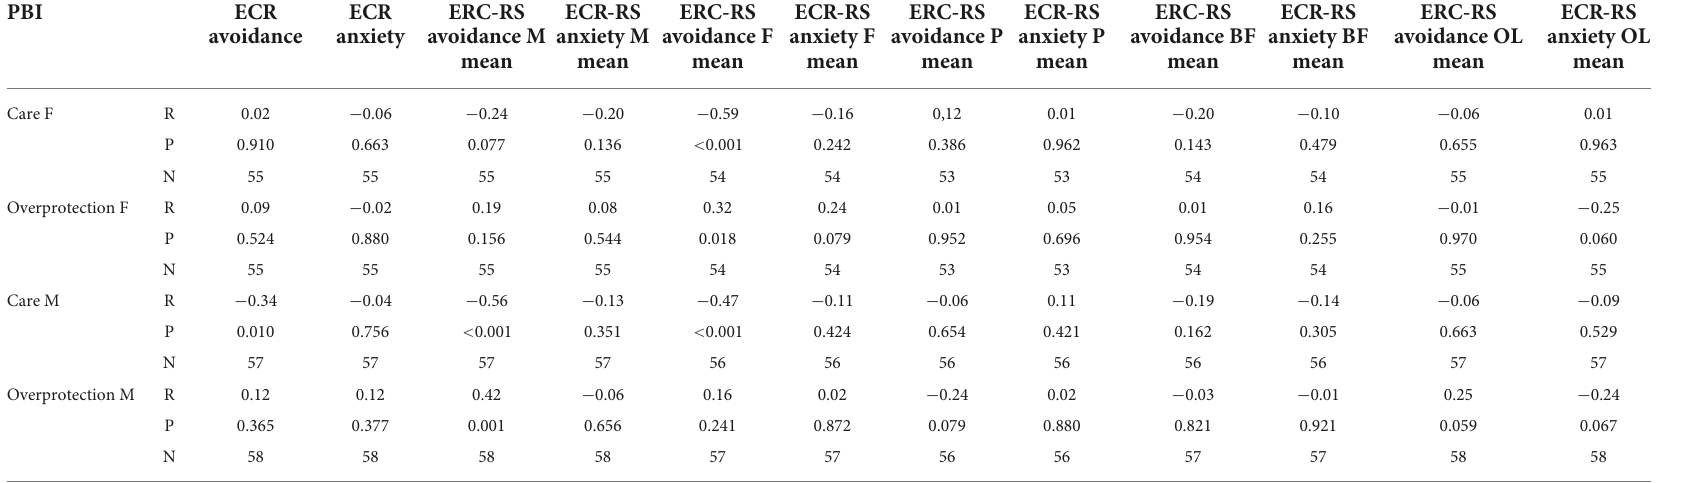
TABLE 6 Spearman correlation between Parental Bonding Inventory (PBI) and Experiences in Close Relationships (ECR) in patients’ group.